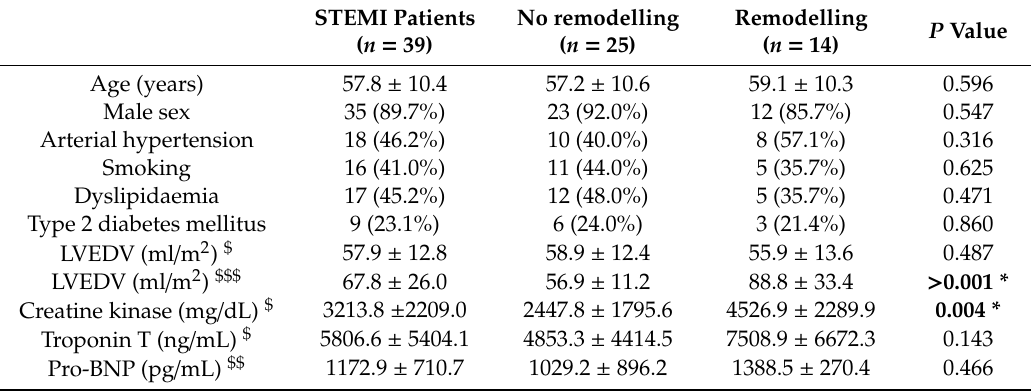
Table 2. Demographic and clinical characteristics of STEMI patients ( n = 39). Patients were classified into two groups: no remodelling ( n = 25) and remodelling ( n = 14). Data are shown as the means ± SEM and as n (%). Student’s t-tests were performed. LVEDV stands for the left ventricular end-diastolic volume; (*) indicates that p < 0.05 is statistically significant; $ indicates that the variable was examined at admission, $$ at 1 month after PPCI and $$$ at 6 months after PPCI. STEMI Patients No remodelling Remodelling ( n = 39) ( n = 25) ( n =